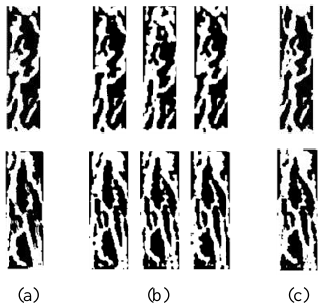
Figure 12. The results for template improvement based on weight average approach. ( a ) templates generated by the weight average approach; ( b ) samples for template improvement; ( c ) improving template using weight average approach. (The samples in the first row are from the HKPU Database and the samples in the second row are from the FV-USM